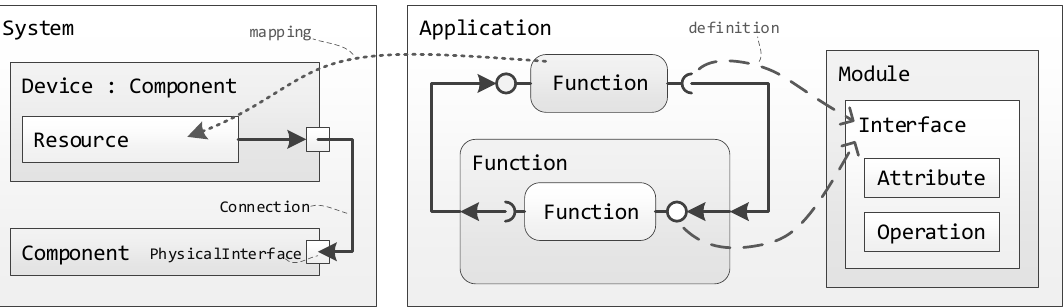
Figure 7. Elements of the Power System Automation Language (PSAL)